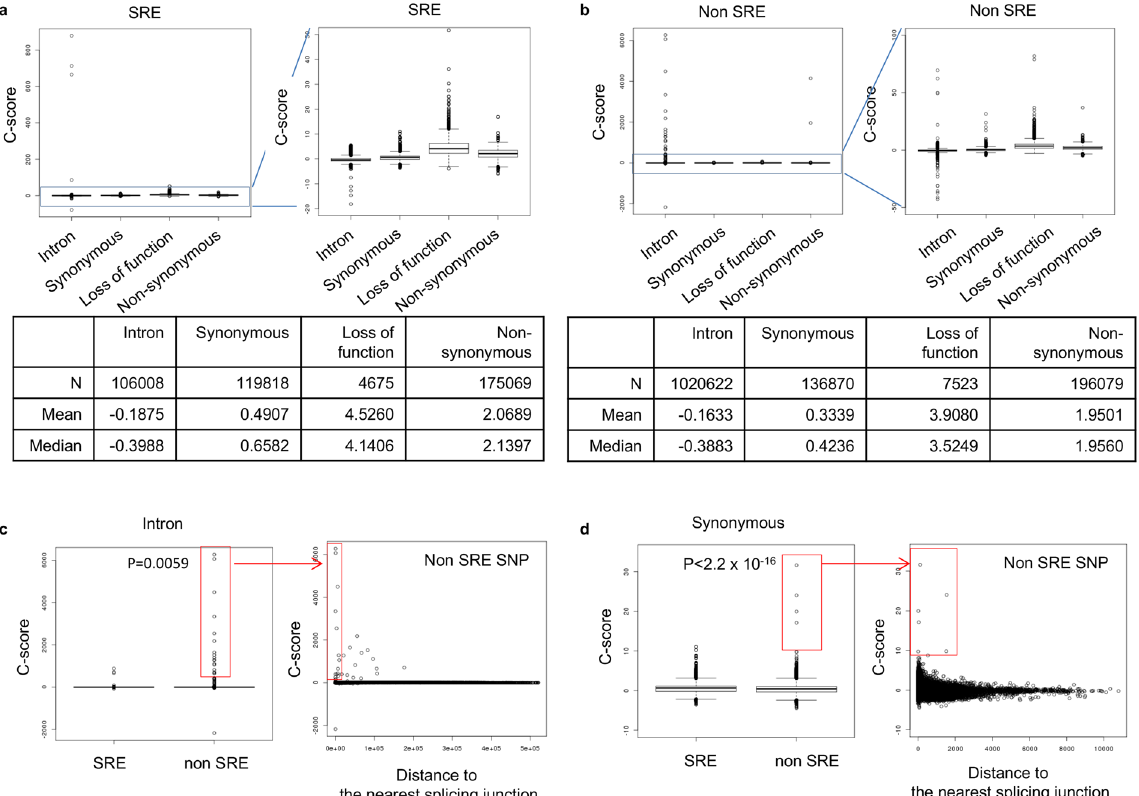
Figure 4. Pathogenicity of SRE SNPs in each SNP class. We used the C-score calculated from the Combined Annotation-Dependent Depletion method. ( a ) Distribution of C-score for SRE SNPs in each SNP class. ( b ) Distribution of C-score for non-SRE SNPs in each SNP class. ( c ) Thirty-four outliers with high C-score (defined as C-score > 10) at intronic non-SRE SNPs have shorter distance to the nearest splice junction than expected. A significant difference (P = 0.0059) in C-score between SRE and non-SRE SNPs within introns was observed. ( d ) Four outliers with high C-score (defined as C-score > 10) at synonymous non-SRE SNPs have shorter distance to the nearest splice junction than expected. A significant difference (P < 2.2 × 10 − 16 ) in C-score between synonymous SRE and synonymous non-SRE SNPs was observed. P-values shown are those obtained after excluding the outlier